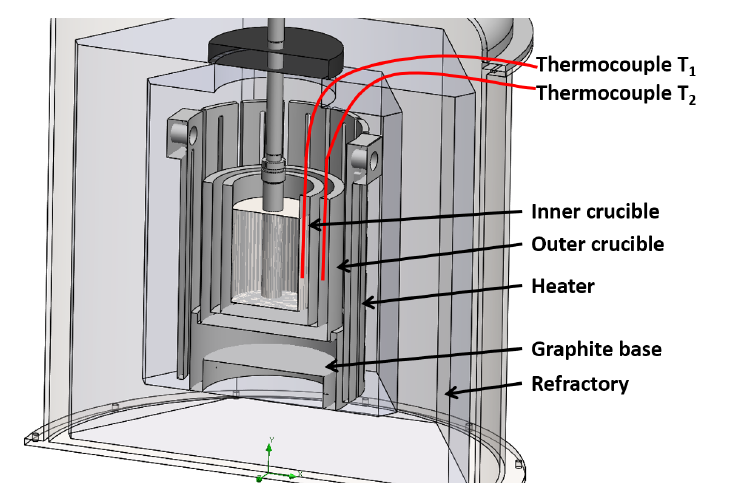
Figure 4. Experimental setup used for the purification of germanium via cooled finger installed in a vacuum resistance furnace.